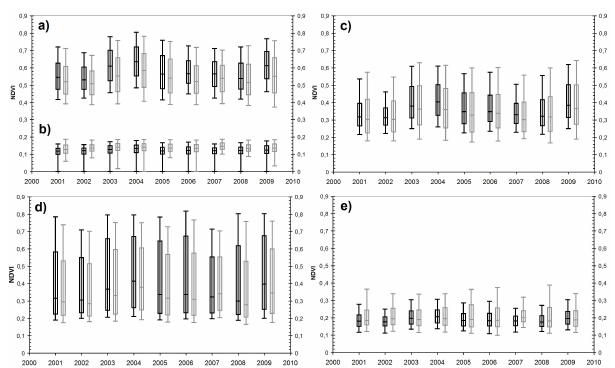
areas and areas with scarce vegetation (e.g. cities) low